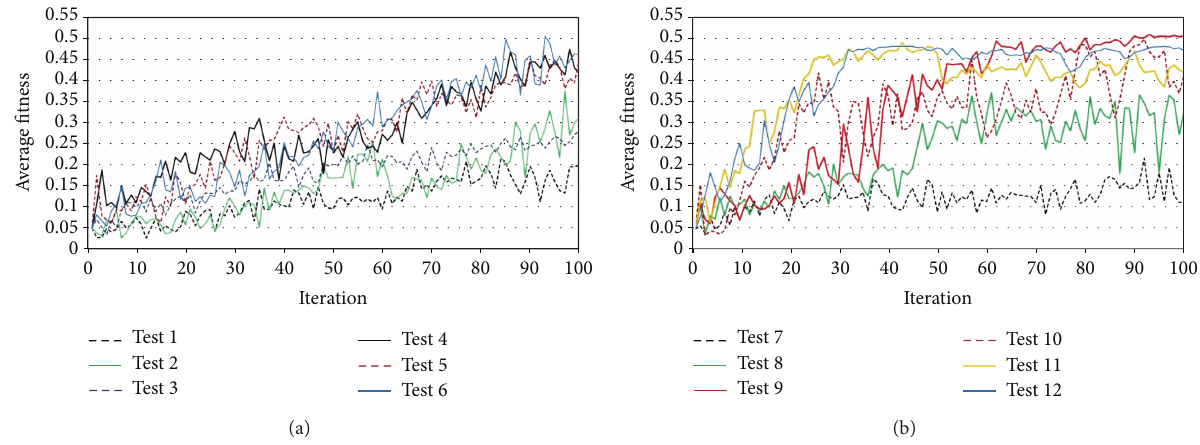
Figure 8: Results of sensitivity tests on (a) unequal and (b) equal coefficients.